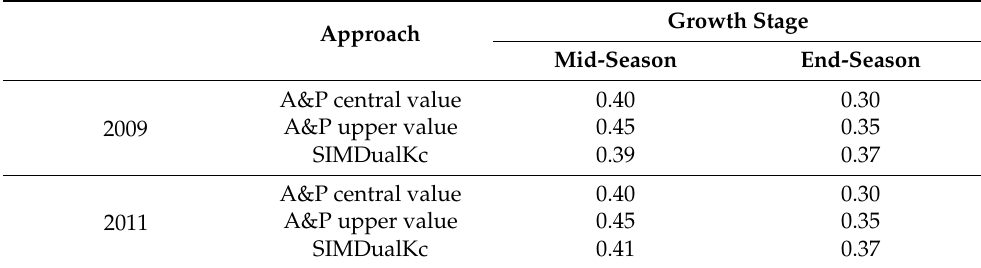
Table 8. Estimated time-averaged K cb act values for the mid- and end-season stages using the A&P approach and the SIMDualKc model for the experimental years 2009 and 2011. Growth Approach